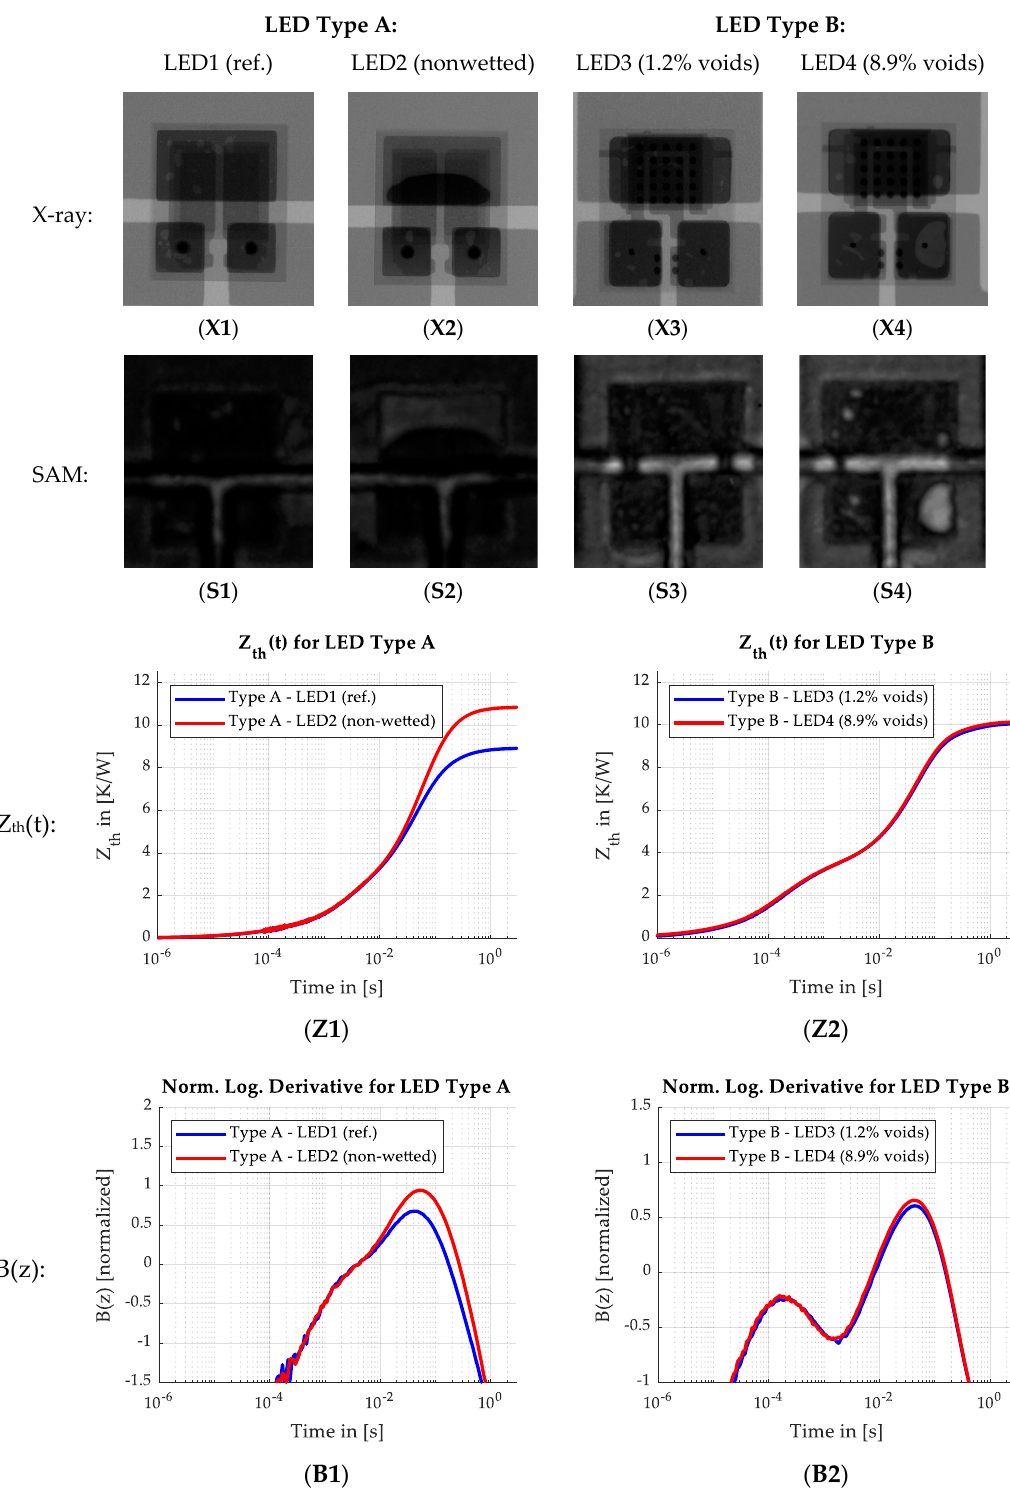
Figure 6. Comparison of nondestructive testing methods (NDTs) for soldered interconnects on four power LEDs. ( X1 ) to ( X4 ) show X-ray images, ( S1 ) to ( S4 ) show SAM images from backside with a 100 MHz transducer (images are vertically mirrored), Z1 and Z2 show Z th (t) plots, and B1 and B2 show the normalized logarithmic derivative, whereby ( X1 ), ( X2 ), ( S1 ), ( S2 ), ( Z1 ), and ( B1 ) belong to two LEDs of Type A and ( X3 ), ( X4 ), ( S3 ), ( S4 ), ( Z2 ), and ( B2 ) belong to two LEDs of Type B. For ( B1 ) and ( B2 ), the normalization interval was set between 0.1 ms and 1 ms resulting in a peak increase of 0.12 or 0.02.